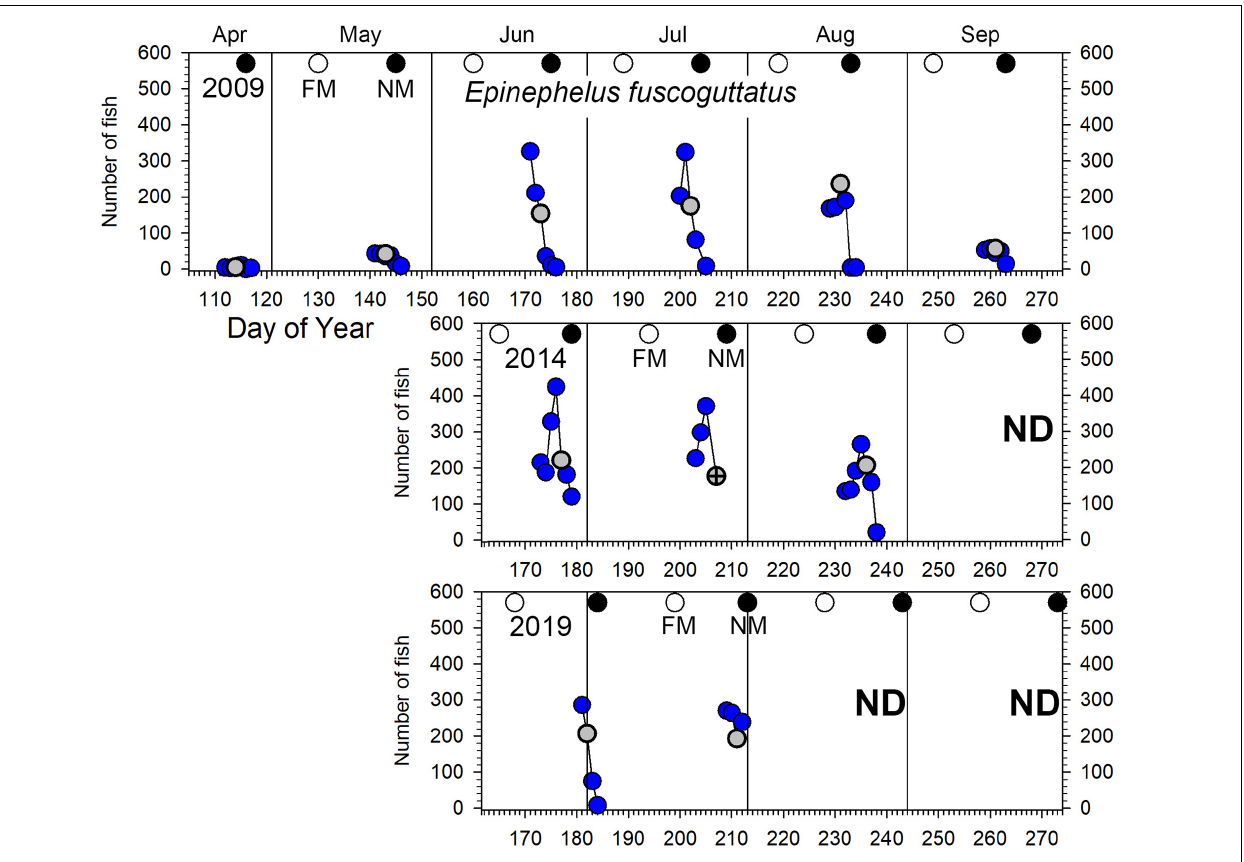
FIGURE 5 | Number of E. fuscoguttatus counted in UVC surveys across the Ebiil site in 2009, 2014, and 2019 for the major aggregation period by day of the year and relative to full and new moon phases. The gray circles indicate day 3 before new moon (3 BNM), except for July 2014 when poor weather precluded surveys for which the survey 2 days BNM is displayed with a cross in the gray circle. ND, no data.